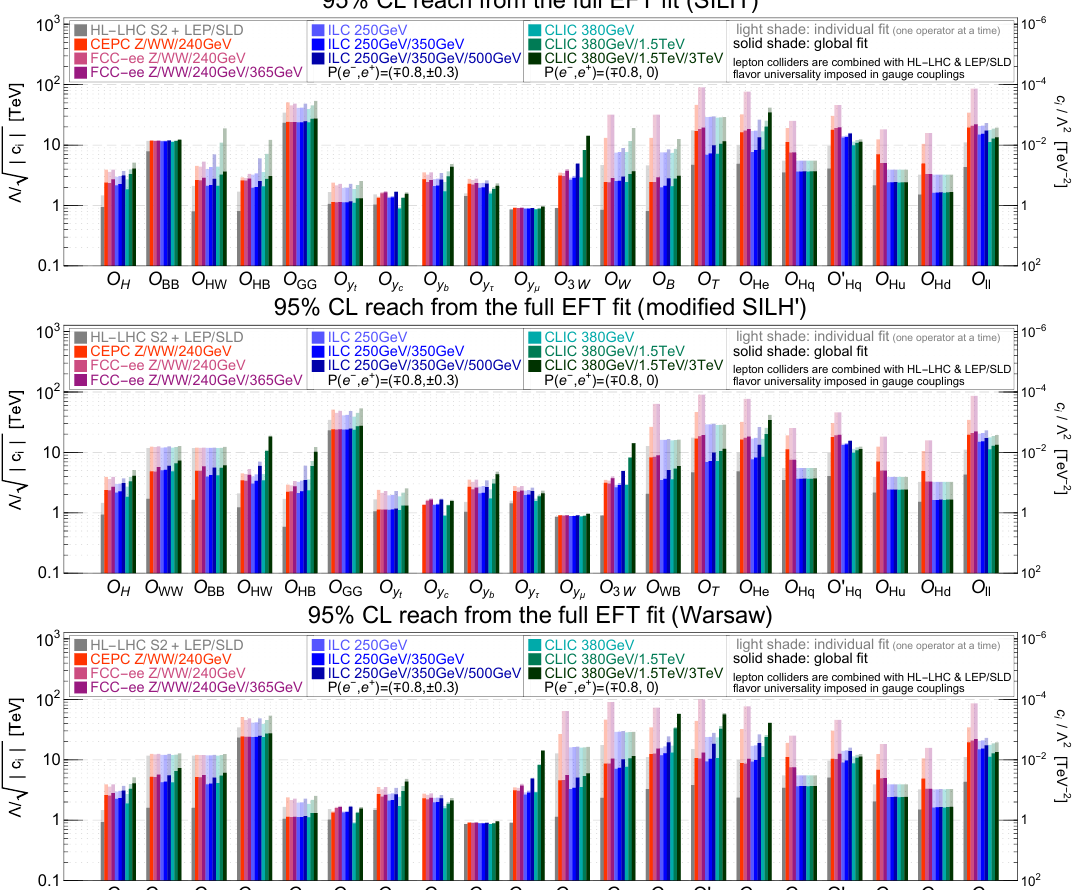
p Figure 10 . The 95% CL reaches for (cid:3) = j c i j for HL-LHC and the future lepton colliders in the SILH’ (top), modi(cid:12)ed-SILH’ (middle) and Warsaw (bottom) bases. The corresponding values for c i = (cid:3) 2 are shown on the right-hand side in units of [TeV (cid:0) 2 ]. The columns with solid shades shows the results from a global (cid:12)t, and the ones with light shades are obtained by switching on one operator at a